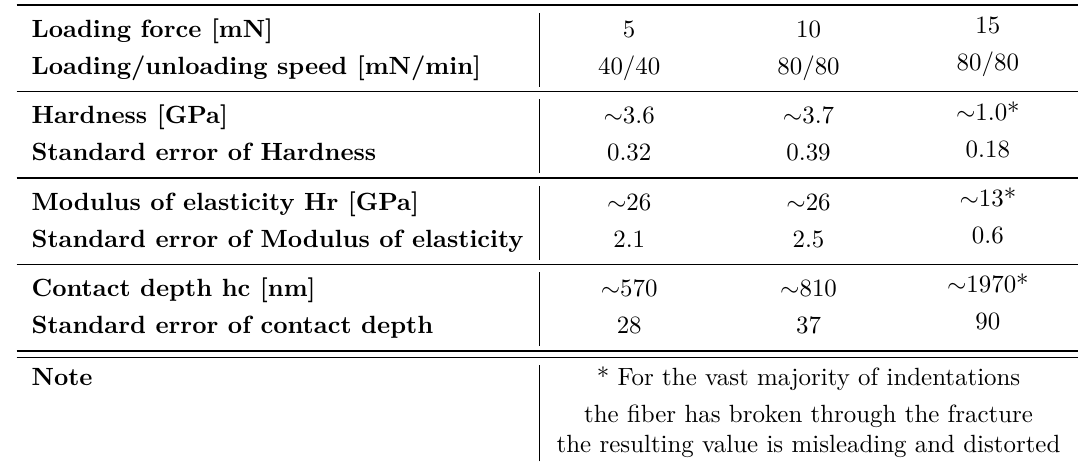
Table 1. The results of indentations in the cross-section of the fibers – indented in the direction of the longitudinal axis of the fiber.